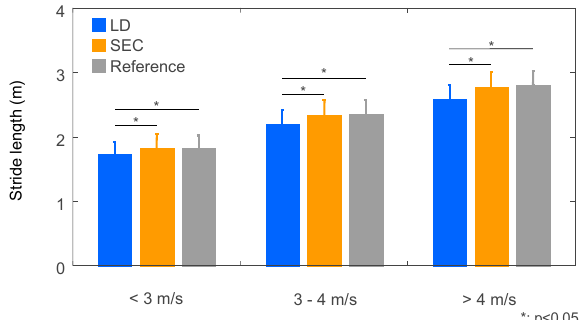
Figure 9. Mean and standard deviation of stride length estimated by linear dedrifting (LD) and spatial error correcting methods (SEC) with measured stride length at different speed ranges. Table 4. Mean and standard deviation of error and absolute error of estimated stride length by linear dedrifting (LD) and spatial error correcting method compared to the reference.